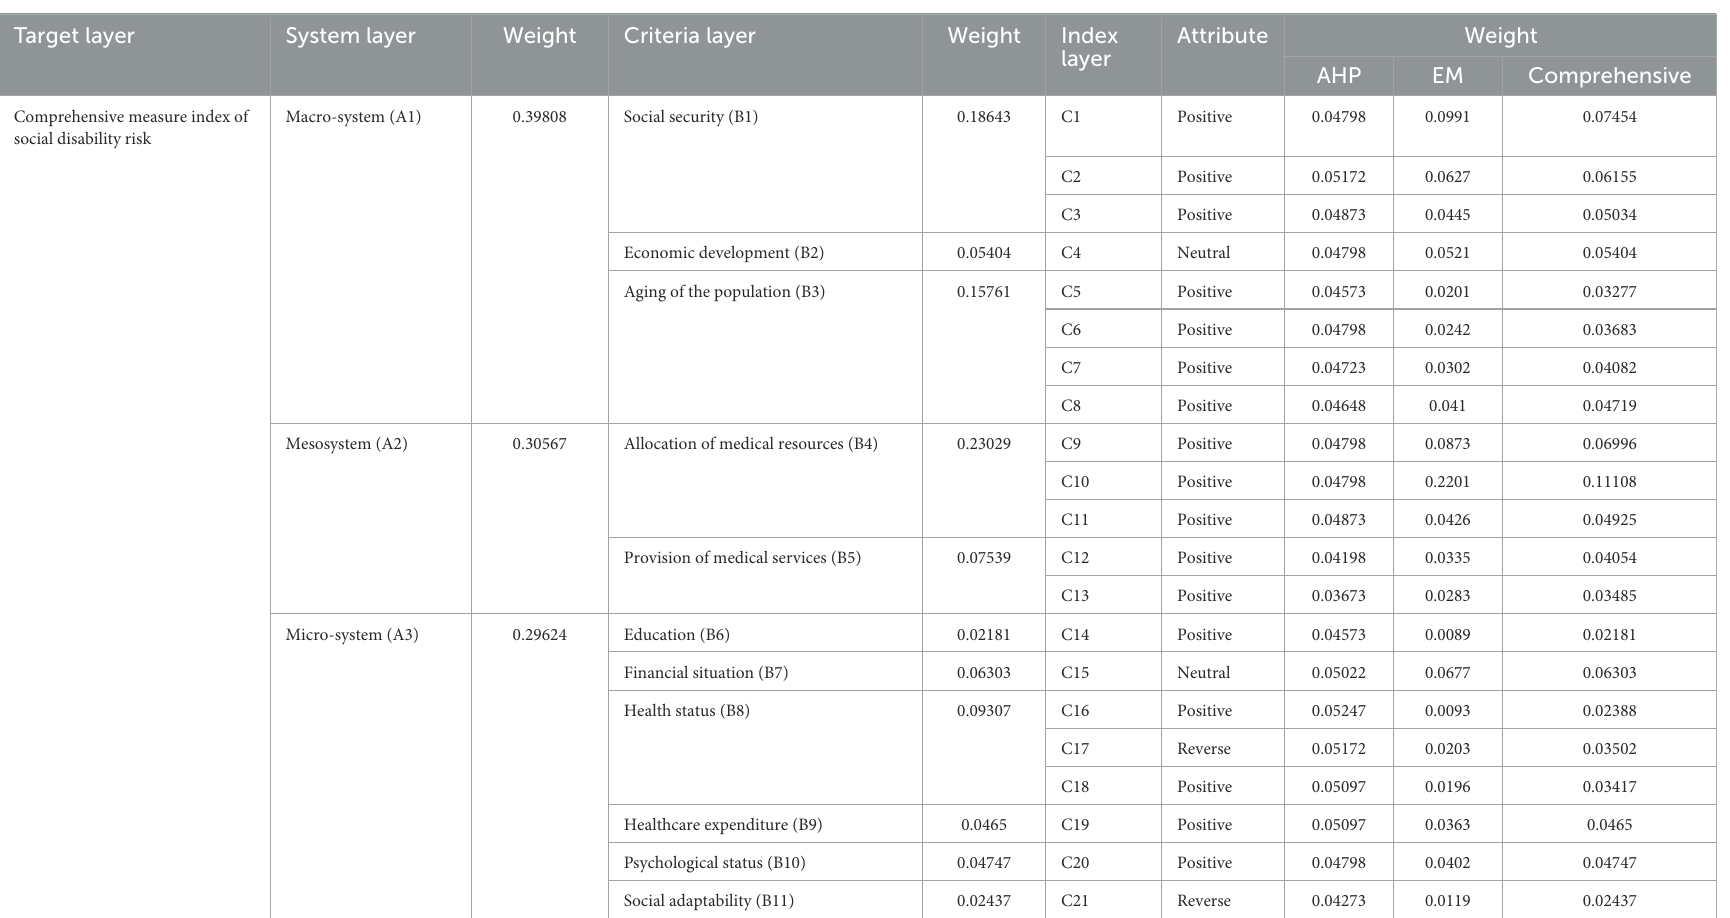
TABLE 5 The indicator weight of the social disability risk measurement